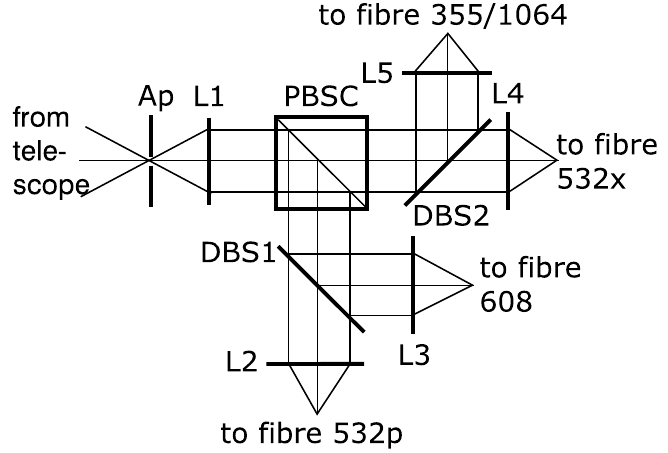
Fig. 2. Optical setup of a focal box. See text for